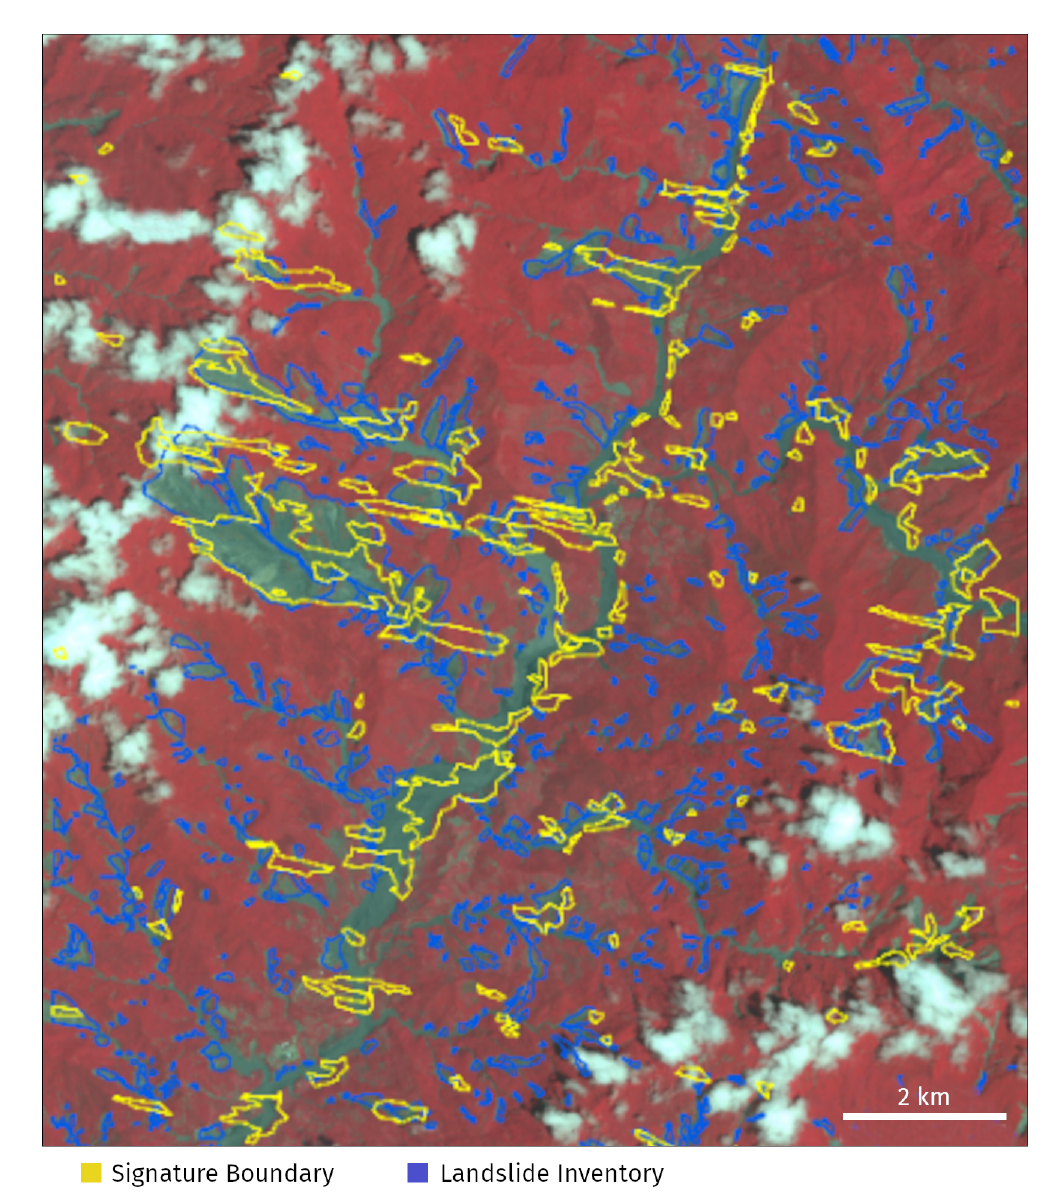
Figure 12. Detected landslides (yellow polygons) superimposed on confirmed landslide inventory data (blue polygons) based on the processing workflow presented and discussed in this contribution. The base map is a SPOT-5 image acquired after the typhoon. Image center located at 120 ◦ 48 (cid:48) E / 23 ◦ 13 (cid:48)